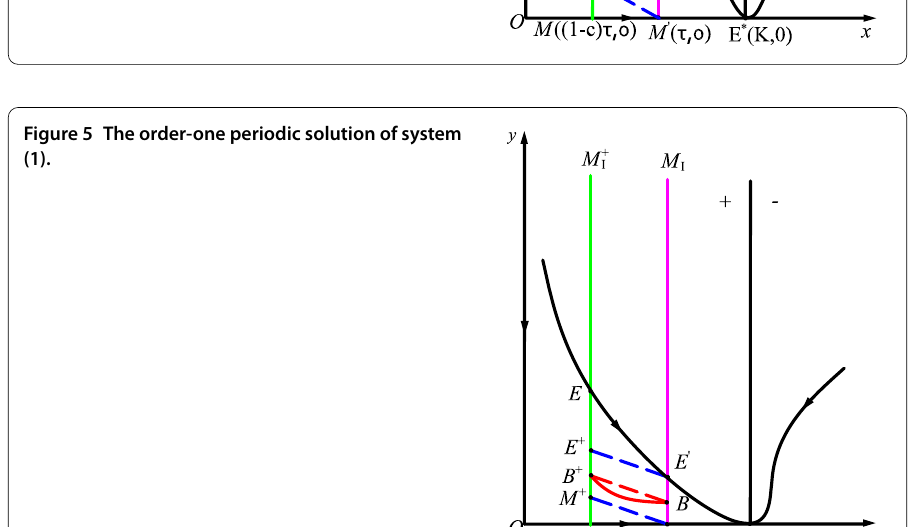
Figure 5 The order-one periodic solution of system